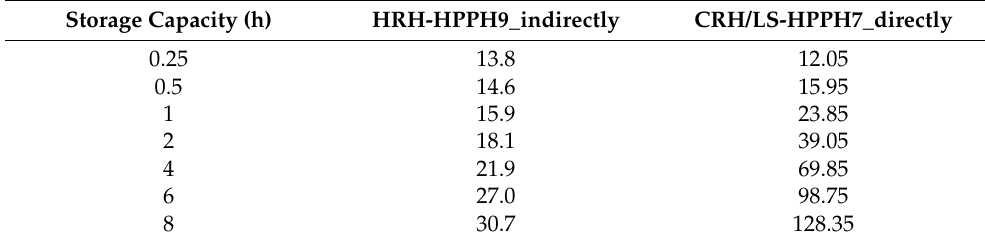
Table 10. Total costs in relation to storage size (discharge hours at full load) in EUR million.